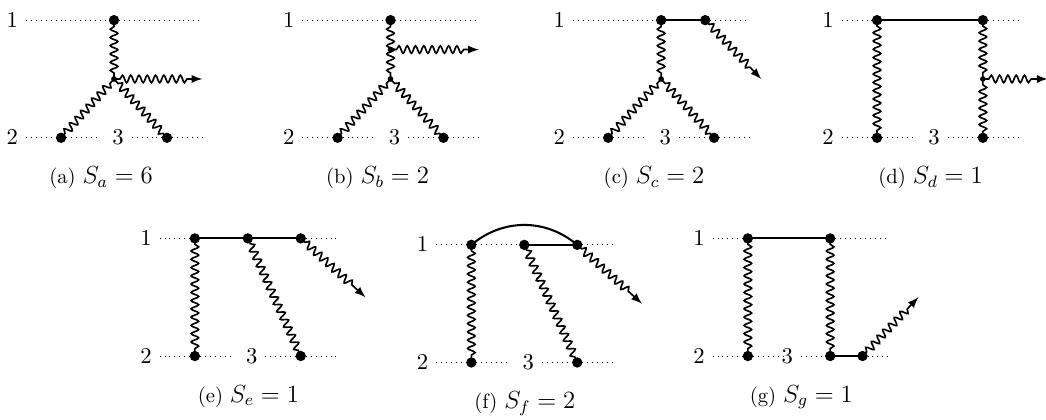
Figure 3. The seven diagrams contributing to the radiation k 2 h h µν ( k ) i WQFT at order 3PM, and their respective symmetry factors. All seven graphs represent tree-level contributions, the worldlines being drawn only as a visual aid. The outgoing momentum from each worldline is q µ